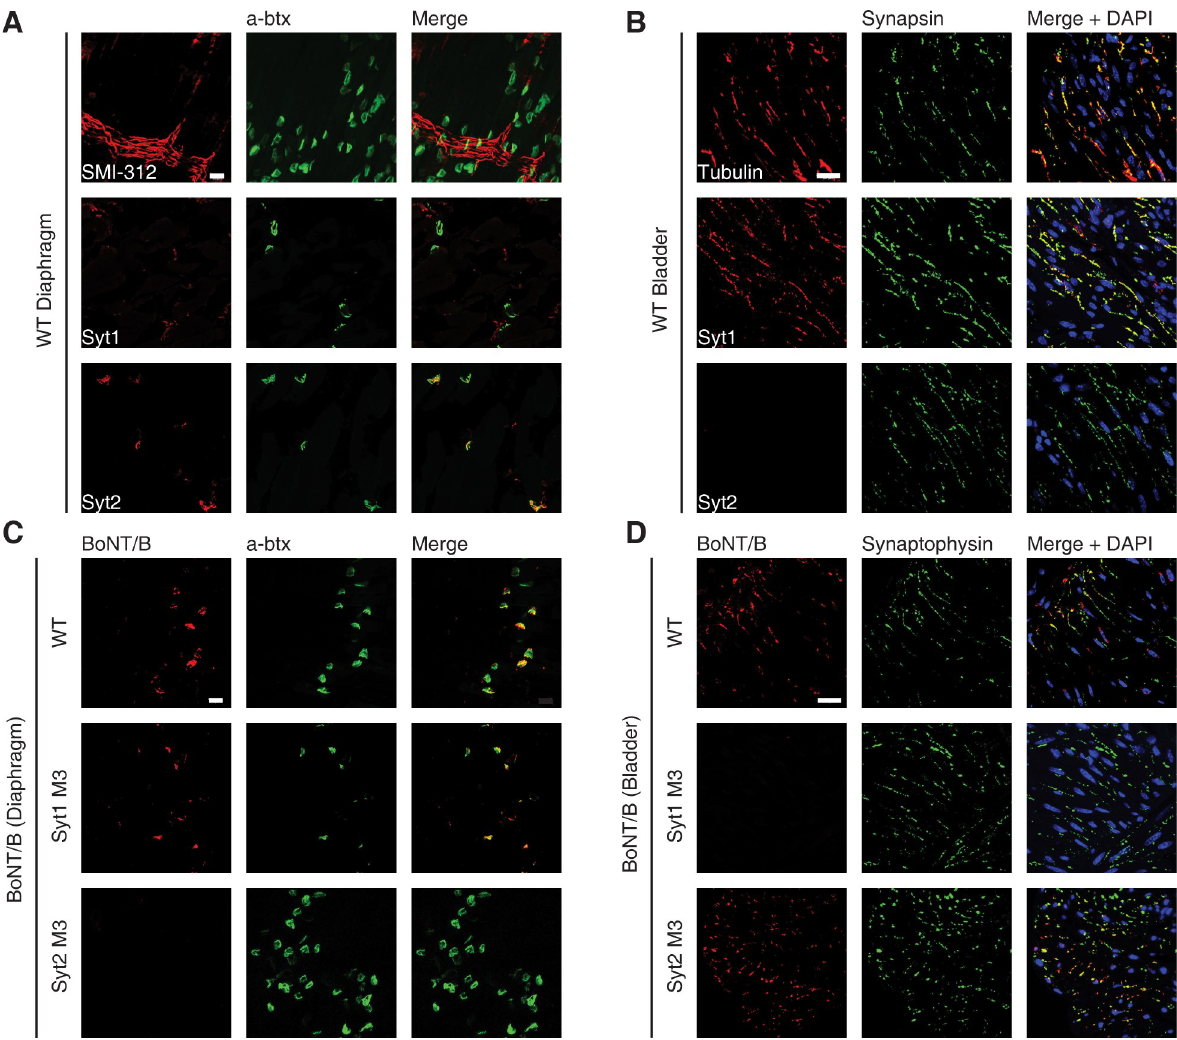
Fig 2. Syt2 and Syt1 are differentially expressed at the mouse diaphragm and bladder. A. Immunohistochemistry analysis detected expression of Syt2, but not Syt1, in motor nerve terminals at WT mouse diaphragm neuromuscular junctions (NMJs). SMI-312 antibody detects neurofilament and marks the phrenic nerve. α -Bungarotoxin (a-btx) labels post-synaptic acetylcholine receptors and serves as a marker for NMJs. Scale bar, 20 μ m. B. Immunohistochemistry analysis of bladder sections from WT mice detected expression of Syt1, but not Syt2 in neurons. β -3 tubulin marks nerve fibers and synapsin marks the pre-synaptic site of neuronal varicosities in bladder tissues. Scale bar, 20 μ m. C. Diaphragms isolated from WT, Syt1 M3 KI, or Syt2 M3 KI mice were incubated with BoNT/B (100 nM, 90 min) in high K + buffer. Tissues were washed, and immunohistochemistry analysis was performed on whole mount tissues. BoNT/B binding and entry was detected on both WT and Syt1 M3 , but not Syt2 M3 diaphragms. D. Bladder tissues isolated from WT, Syt1 M3 , or Syt2 M3 mice were incubated with BoNT/B (100 nM, 90 min) in high K + buffer. Tissues were washed, and immunohistochemistry analysis was performed. BoNT/B binding and entry was detected on both WT and Syt2 M3 , but not Syt1 M3 bladders. Representative images were selected from n = 3–4 biological replicates.